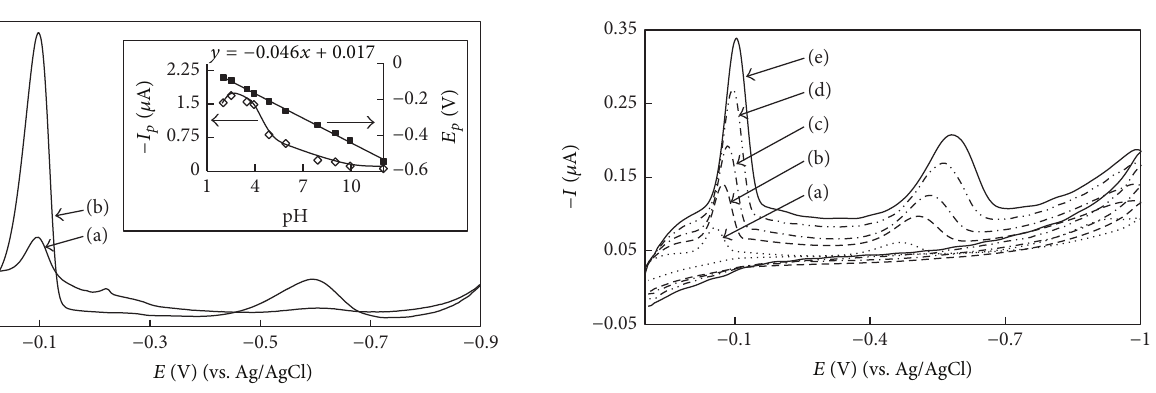
Figure 2: SW voltammograms for 2 × 10 −6 molL −1 NT solution in citrate (a) and Britton-Robinson (b) buffer (pH = 2.5), frequency 50 Hz, step potential 5mV, and amplitude 50mV. Inset presents pH dependence of nitrothal-isopropyl analytical peak current intensity and position in BR buffer.